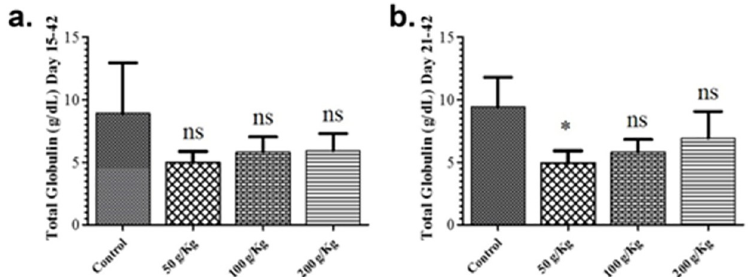
Fig 5. Graph showing the comparison of total globulin of different quinoa enriched diet given chicken groups. The chickens were given 50 g/Kg, 100 g/Kg and 200 g/Kg of quinoa. ( a ). Total globulin levels of chicken fed from days 15 to 42 post-birth ( b ). Total globulin levels of chicken fed from days 21 to 42 post-birth. All data are expressed as means ± standard deviation (SD) from measurements on 15 chickens. � p � 0.05 in all quinoa supplemented diet fed groups versus the commercially available diet without quinoa fed control group. Note : ns means not